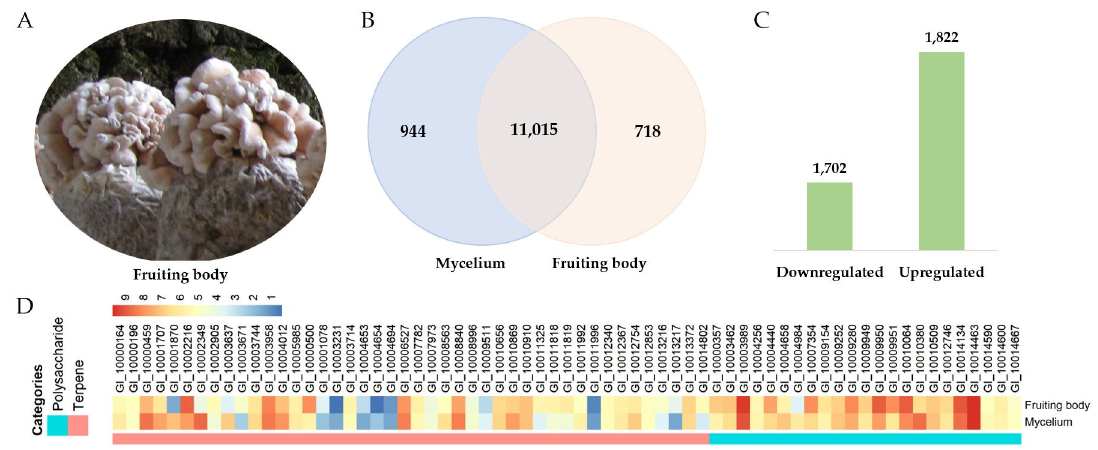
Figure 6. Comparative transcriptome profiling of the mycelium and the fruiting body of G. incarnatum : ( A ) Fruiting bodies of G. incarnatum ; ( B ) Venn diagram of the genes expressed in the mycelium and/or the fruiting body; ( C ) number of genes being significantly downregulated or upregulated in the fruiting body compared with the mycelium; ( D ) heatmap of the genes associated with the biosynthesis of polysaccharides and